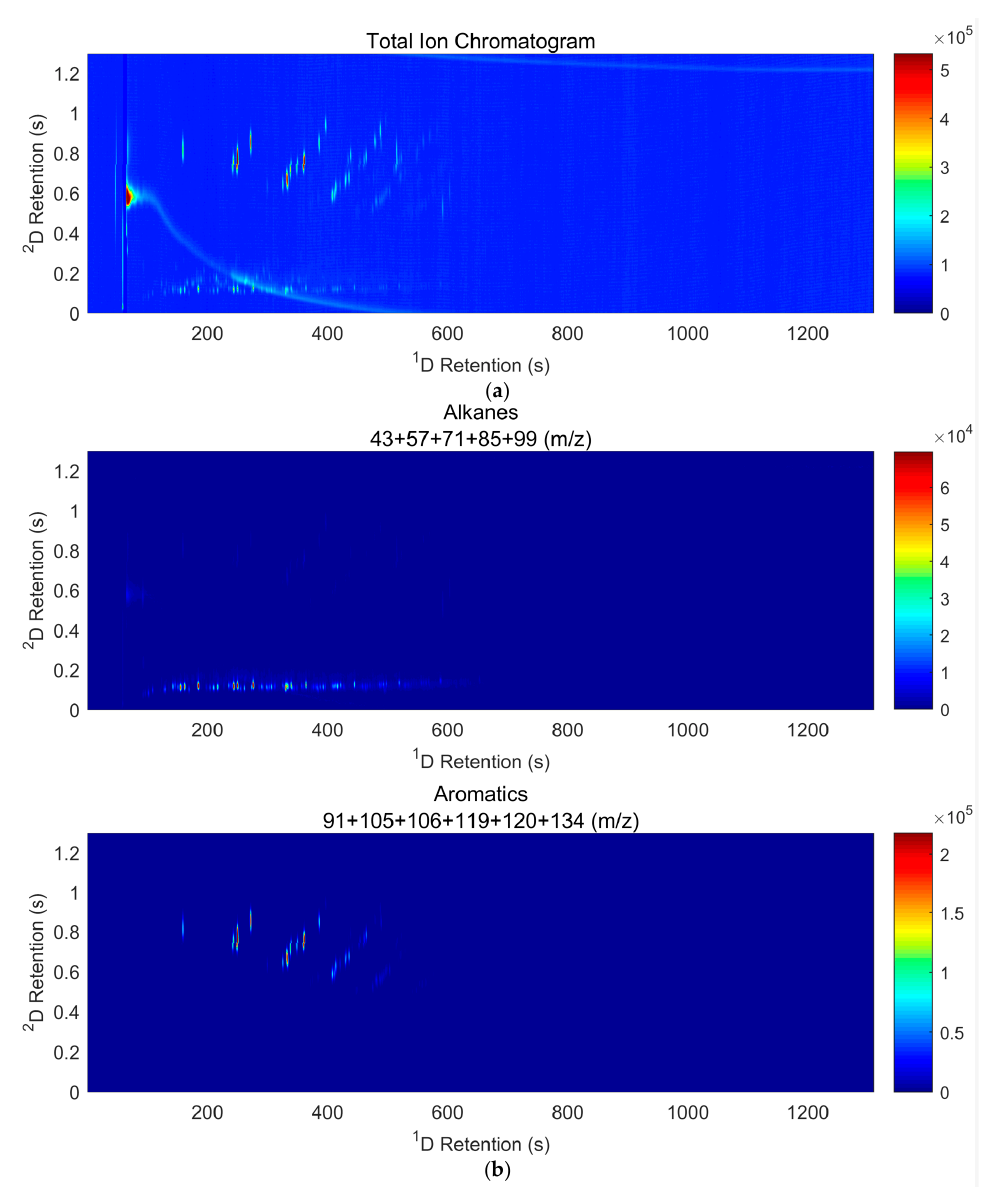
Figure 3. Sample of 2D GC×GC-TOF data for the most abundant gasoline level tested (1.0 μ L/mL) as: ( a ) TIC; and ( b ) summed alkane and aromatic EICs. The 2 D retention axis has been shifted downwards by 0.55 seconds in all figures to account for the 2 D t m . EICs are not provided as overlays of individual ion chromatograms as it is not possible to present them in a meaningful way for the 2D data.